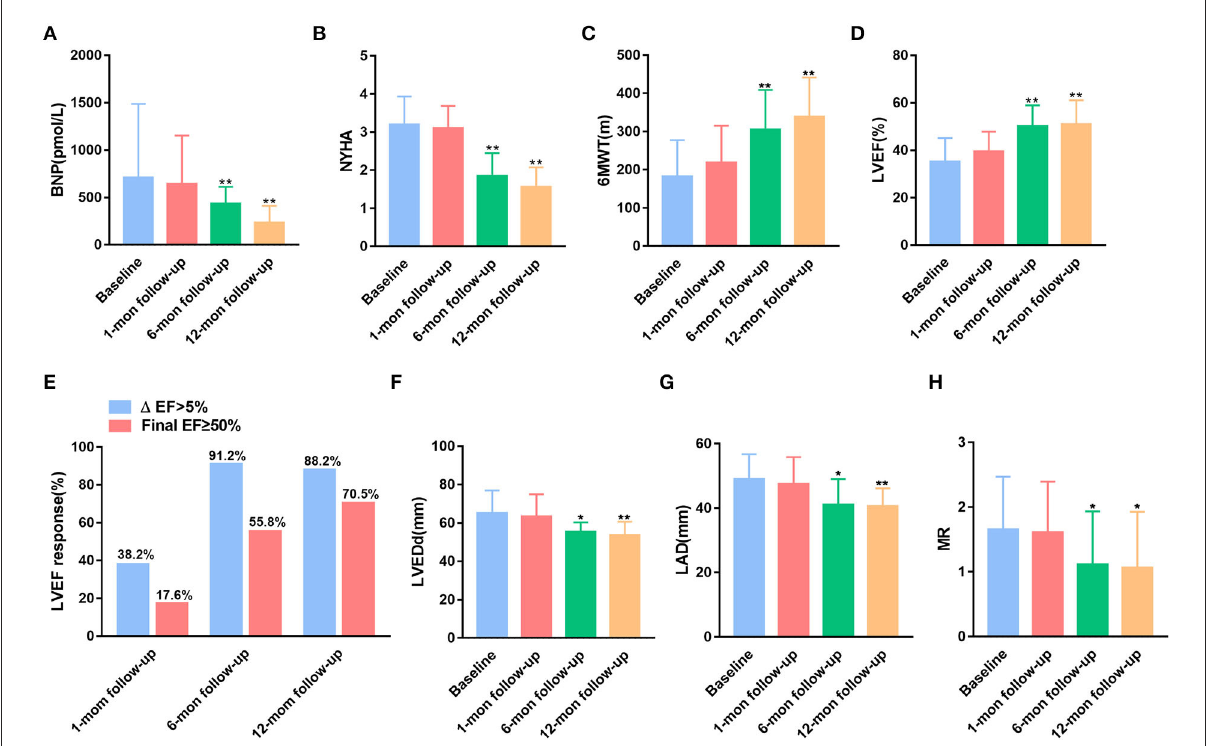
FIGURE2 Comparisons of the New York Heart Association (NYHA) functional class and echocardiographic parameters at baseline and during the follow-up period. (A) Brain natriuretic peptide (BNP). (B) The NYHA classification. (C) 6-Minute walk test (6MWT). (D) Left ventricular ejection fraction (LVEF). (E) LVEF response rate. (F) Left ventricular end-diastolic dimension (LVEDd). (G) Left atrial dimension (LAD). (H) Mitral regurgitation (MR). * p < 0.05, and ** p < 0.01 with